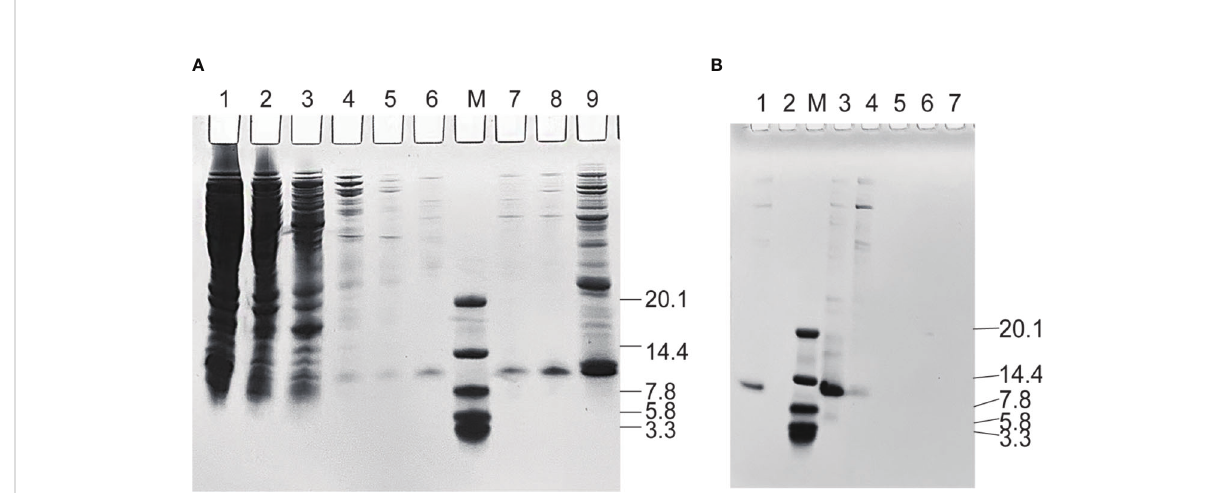
FIGURE 1 Sodium dodecyl sulfate – polyacrylamide gel analysis during the puri fi cation of PDA. (A) Puri fi cation of af fi bodies by immobilized metal af fi nity chromatography. Lane M, the protein molecular marker (kDa), Lanes 1~9 are cell lysate after heat treatment, unbound protein, 5, 10, 20, 30, 40, 60, and 300 mM imidazole-eluted product, respectively. (B) Puri fi cation of af fi bodies by anion exchange. Lane M, the protein molecular marker (kDa); Lane 1~7 sequentially are sample eluted with 60 mM imidazole and 50, 200, 500, 800, 1,200, and 4,000 mM NaCl-eluted